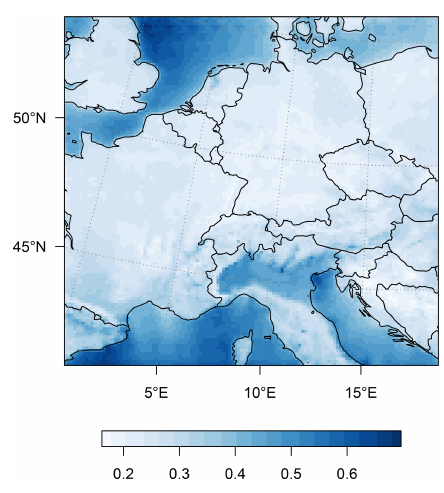
Figure C2. Temperature anomalies. MSE for each grid cell for the temperature predictions.